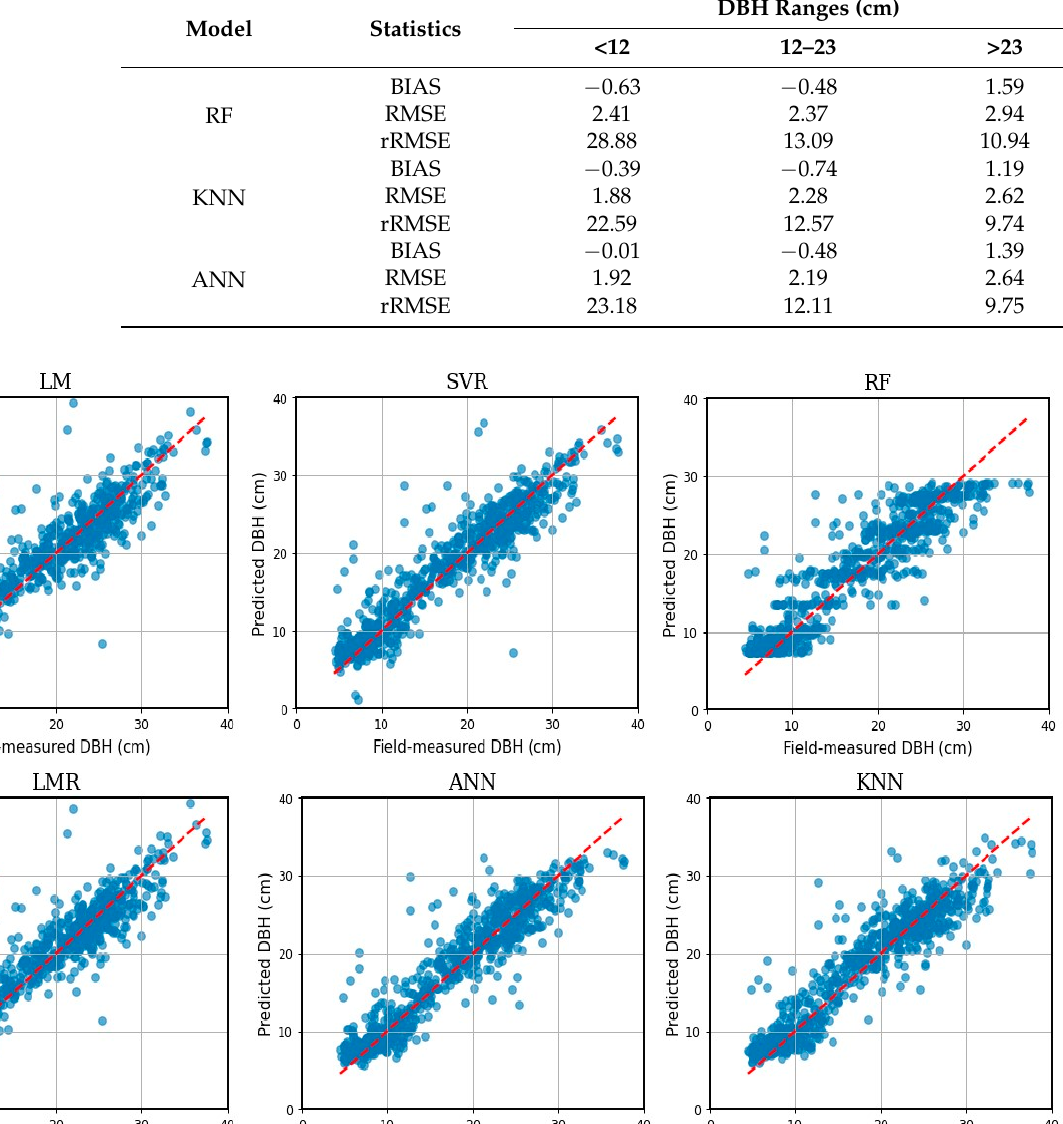
Table 7. Summary of accuracy assessment results for the validation dataset for different DBH ranges. Positive bias indicates underestimation.